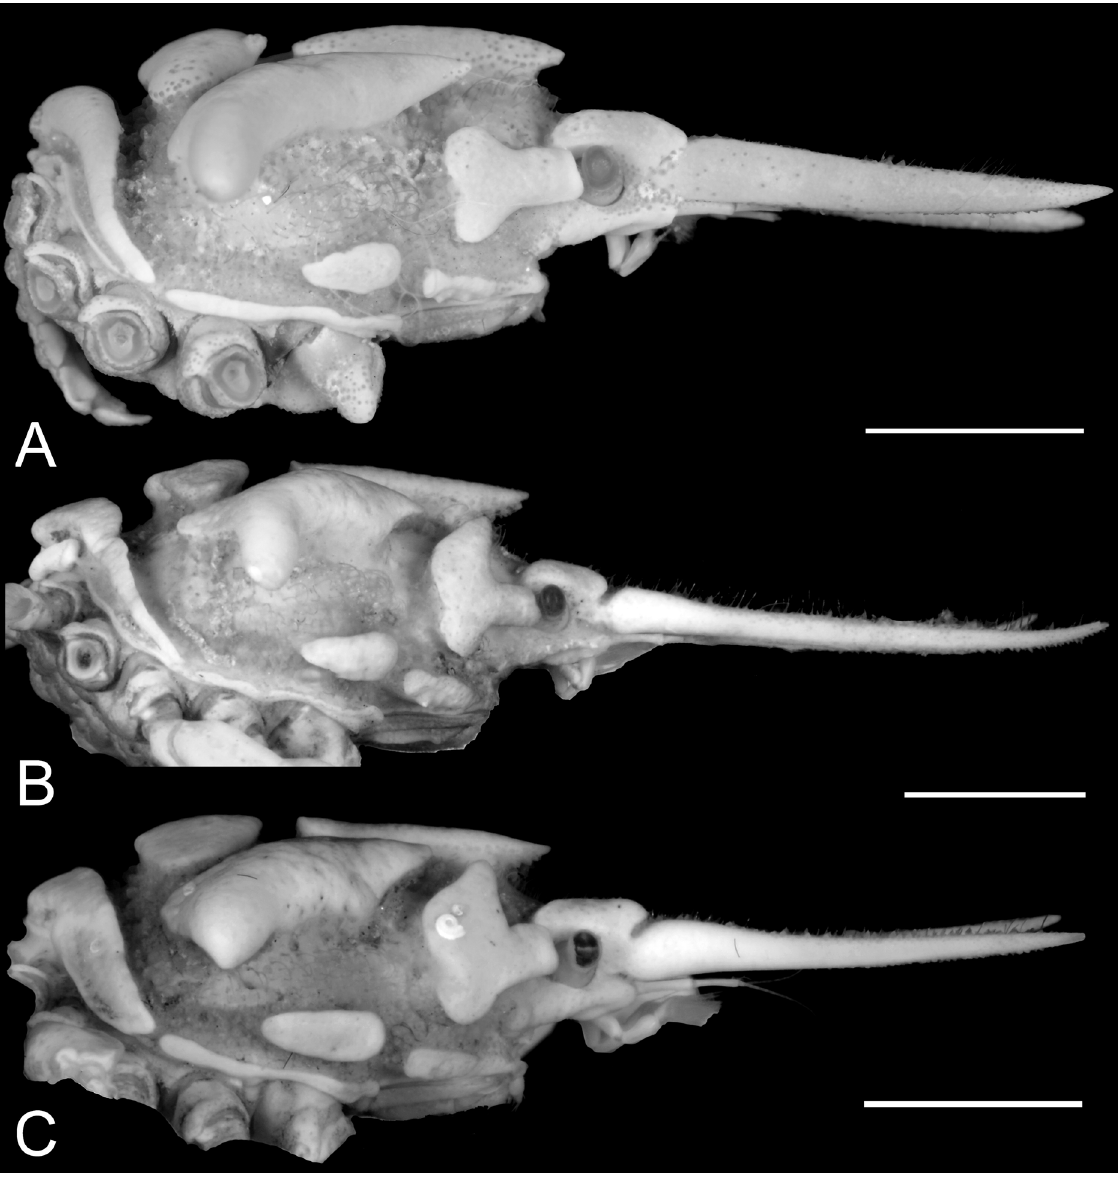
Fig. 3. Oxypleurodon stimpsoni Miers, 1885, lateral view of carapace. A . ♂ (14.0 × 9.0 mm) (AM P34658), Indonesia. B . ♂ (14.9 × 10.2 mm) (ZRC 2011.0056), Philippines. C . ♂ (14.0 × 9.0 mm) (ZRC 2016.0072), South China Sea. Scale bars =